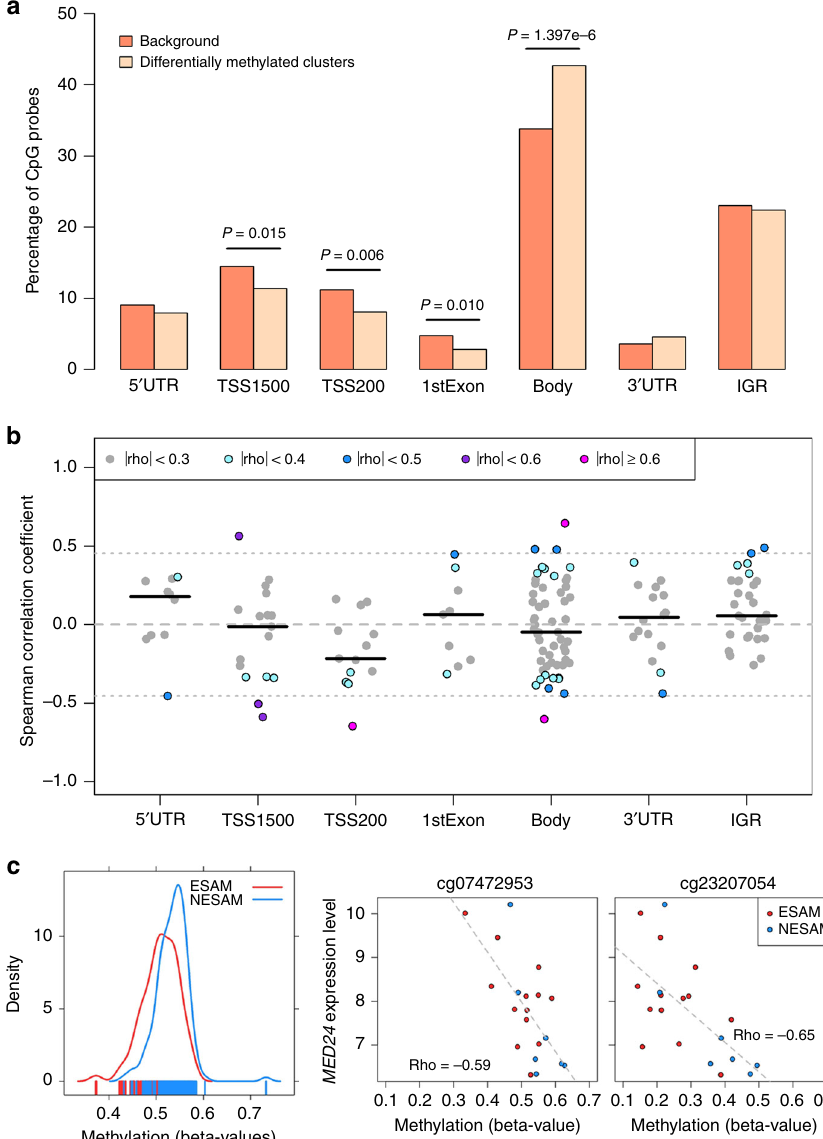
Fig. 3 Gene feature enrichment and expression analysis. a Gene annotation enrichment analysis for CpG probes within signi fi cant differentially methylated clusters (DMCs) from the analysis of acutely malnourished children. P values were calculated with hypergeometric tests of depletion or enrichment comparing N = 420,500 of all tested, background CpG probes with the subset of N = 630 CpG probes found within DMCs. b Intraindividual correlation (Spearman) between mean methylation and mean expression of highly expressed genes within 10 kb in 20 additional Malawian children with SAM at individual CpG probes within signi fi cant DMCs. Horizontal dark bars represent median correlation coef fi cients, dashed line shows correlation of zero, and dotted lines indicate thresholds beyond which correlations reach statistical signi fi cance (algorithm AS 89 t test, P < 0.05). 5 ′ UTR: 5-prime untranslated region, TSS1500: within 1500 bp distance to transcription start site, TSS200: within 200 bp distance to transcription start site, 3 ′ UTR: 3-prime untranslated region, IGR: intergenic region. c Beta-value methylation levels by SAM type in DMC overlapping MED24 (left panel, N ESAM = 164 samples, N = 145 samples) next to scatterplots showing the relationship between methylation levels of probes within the MED24 containing DMC and the NESAM expression values of MED24 (middle and right panel). Gray dashed lines show a linear model fi t, while rho values indicate Spearman correlation coef fi cients. Source data for panels a and c (density plot) are provided as Source Data fi